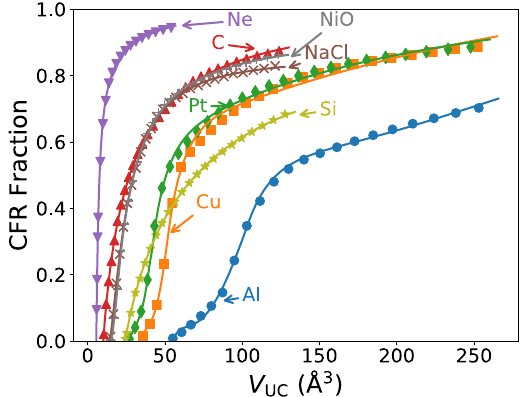
Fig. 2 The role of strain in shaping CFRs. Emergence of PBE CFRs and their volume fractions as functions of the volume per atom in Al (blue closed circles), Cu (yellow squares), Pt (green diamonds), C (red point-up triangles), Ne (purple point-down triangles), NaCl (brown Xs), Si (olive stars), and NiO (gray plus signs) as a function of the unit cell volume. All lines are fi ts given in Supplementary Table II. As Al, Cu, C, and Si have no CFR at their relaxed lattice parameters, each lattice must be stretched to introduce a CFR. Conversely, Ne and NaCl must be compressed to eliminate their CFRs; for completeness, the full NaCl curve is presented here. The curve for spin-unpolarized NiO is almost identical to that of NaCl (see also Supplementary Fig. 3). The LSDA curves are very similar, see Supplementary Fig. 6. For PBE curves as calculated in Castep, see Supplementary Fig. 7.